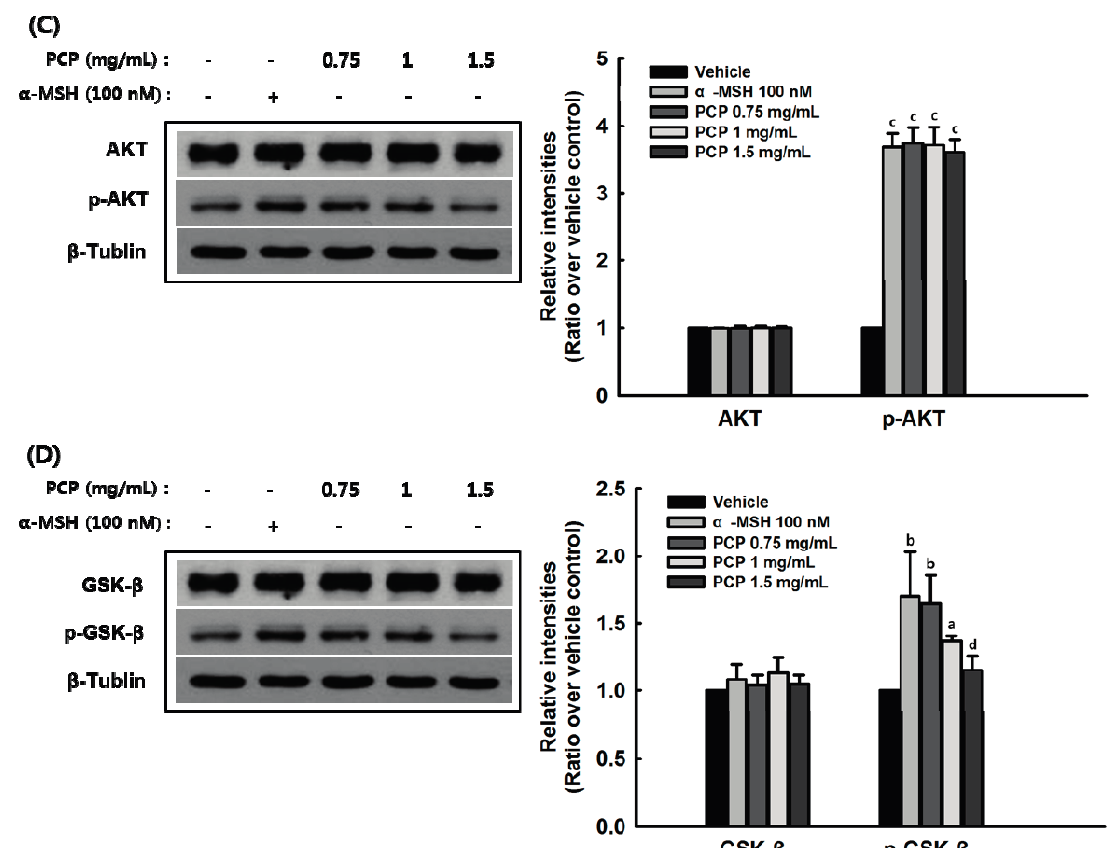
Figure 7. Effects of PCP on melanogenesis-related signaling pathways. B16F10 cells were exposed to various concentrations of PCP (0.75, 1 or 1.5 mg/mL) for 48 h following treatment with or without α -MSH (100 nM) for 24 h. ( A ) ERK, p-ERK, 38 MAPK, p-38, JNK, p-JNK; ( B ) PKA, p-PKA, CREB, p-CREB; ( C ) AKT; p-AKT ( D ) GSK- β , p-GSK- β , and β -tubulin protein levels were examined by Western blot analysis. PCP,